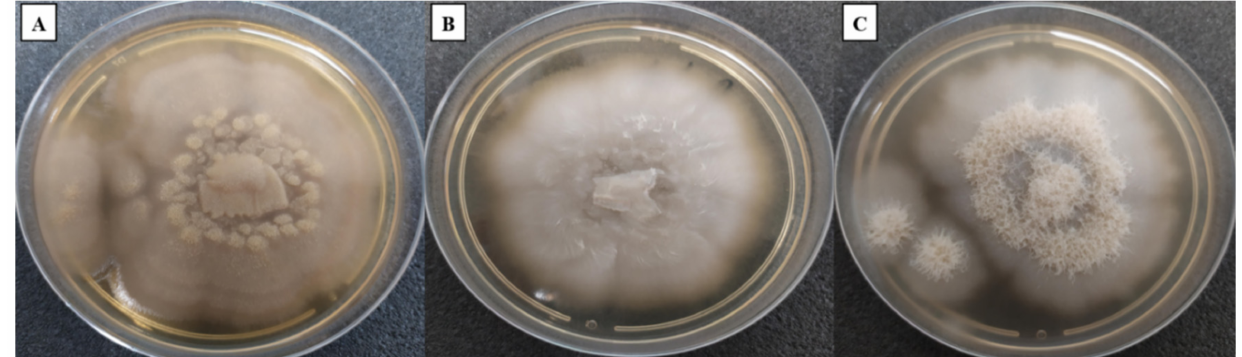
Figure 1. Culture growth on Sabouraud Dextrose Agar + gentamicin and chloramphenicol after five days of incubation at 25 ◦ C. The colour of both the recto and verso of the colonies was white/beige to salmon. ( A ) Coniochaeta massiliensis PMML0158. ( B ) Coniochaeta hoffmannii DSM 2693. ( C ) Coniochaeta mutabilis DSM